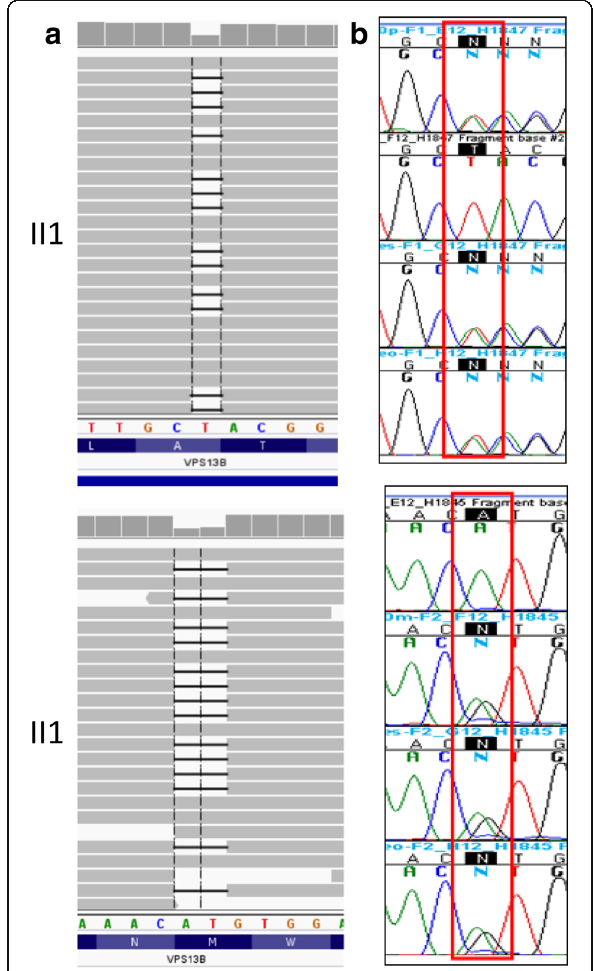
Fig. 2 a Integrative Genomics Viewer of short read alignment indicated the compound heterozygous variant identified by exome sequencing (100,479,778 T/ − ,100712001AT/ − ) in the VPS13B gene. b Sanger validation shows the compound heterozygosity of the proband II1 formed by the c.3582delT mutation, and